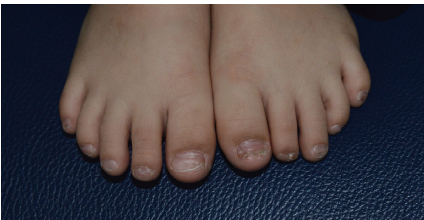
Figure 2: Onychomadesis noted at 2-month follow-up. The toenails on both feet were partially